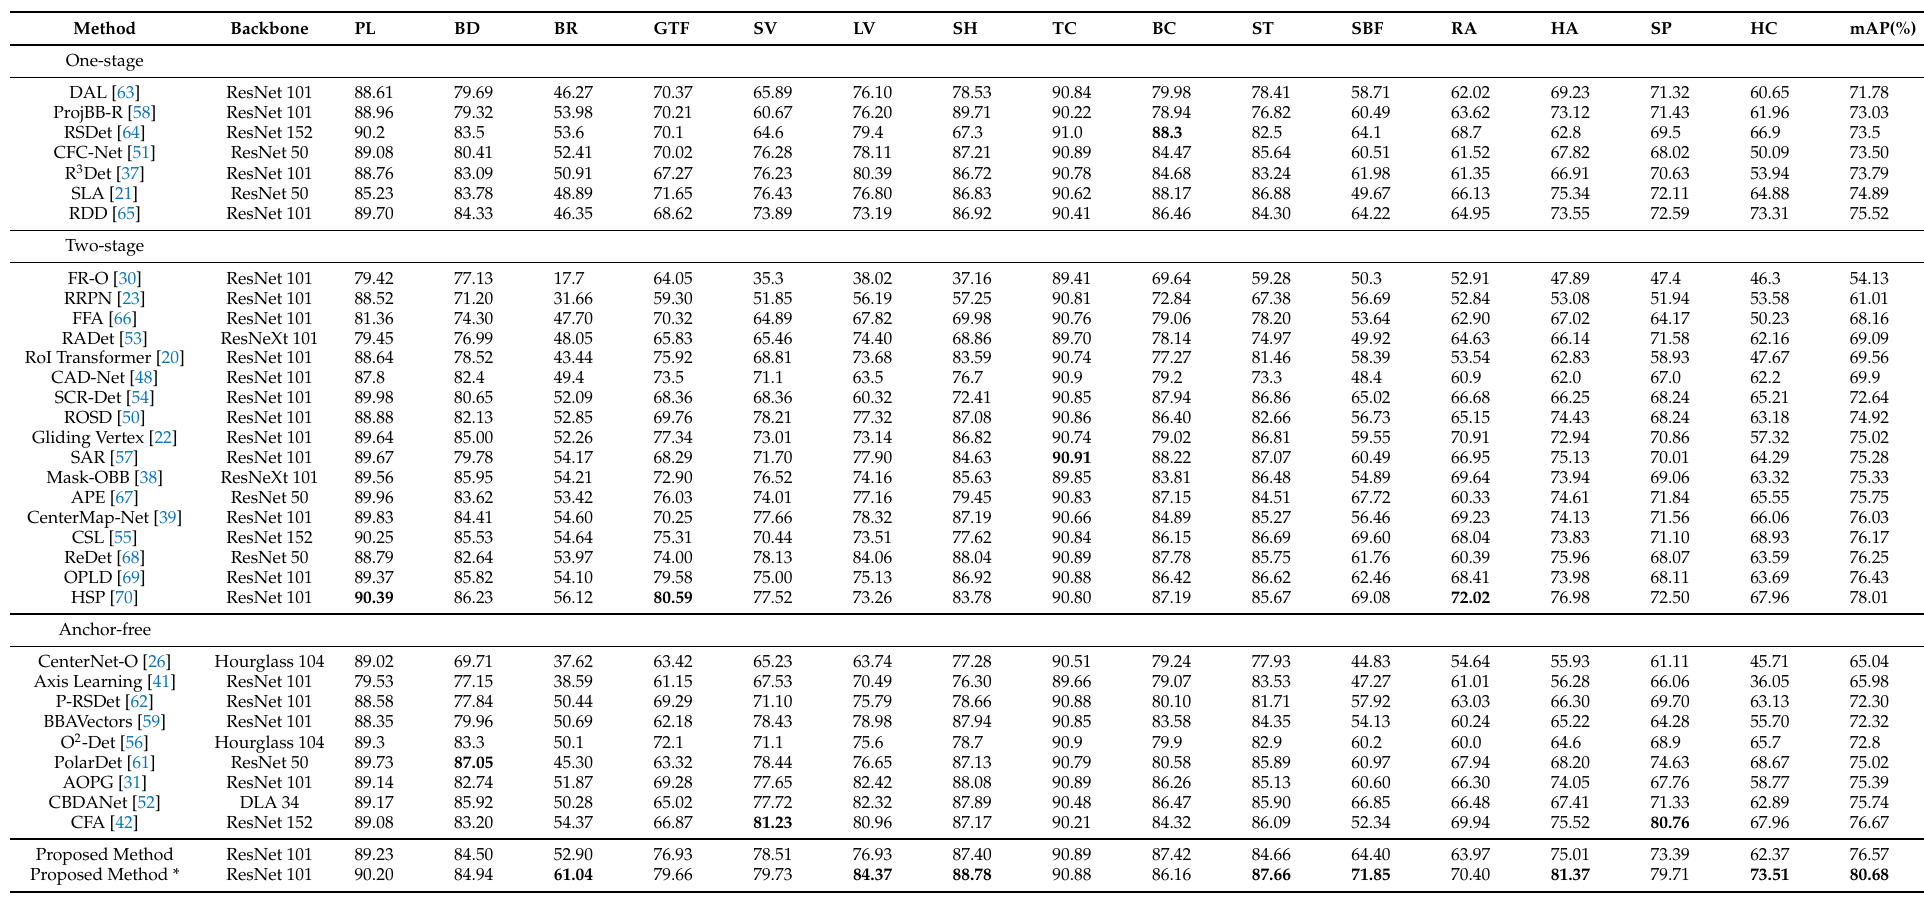
Table 1. Comparisons with state-of-the-art methods on DOTA dataset test set. * means multi-scale training and testing. Bold denotes the best detection